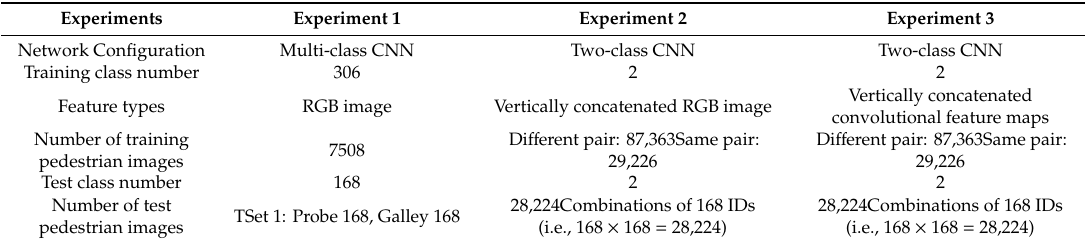
Table 2. List of experimental settings for the identification module evaluation. CNN: convolutional neural